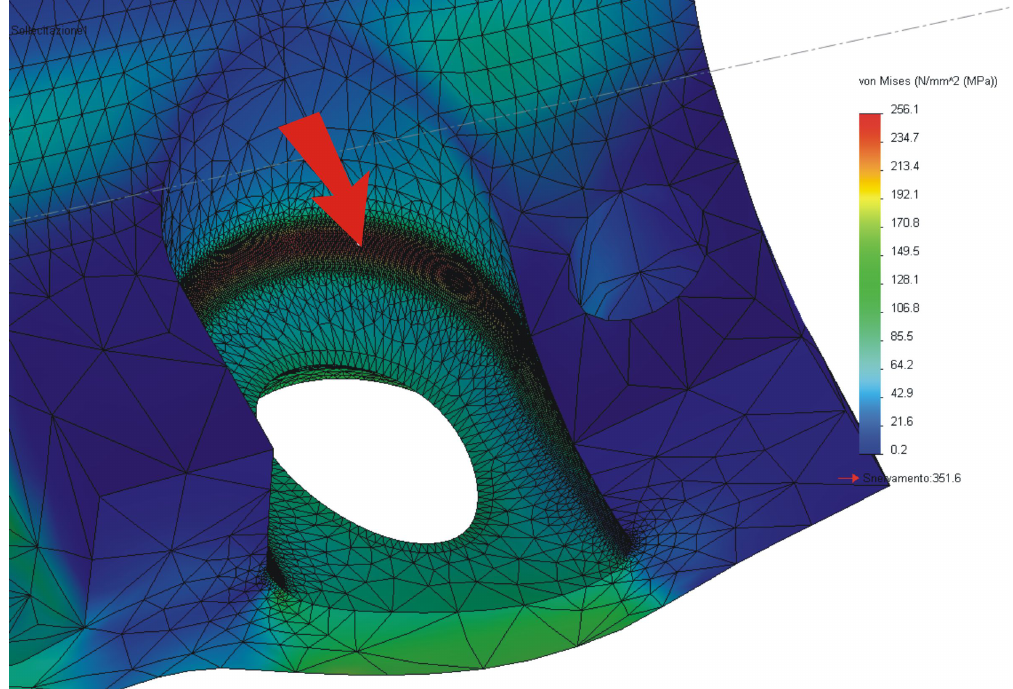
Figure 13: Areas of the base-pole piece set joined by screws where the stress is